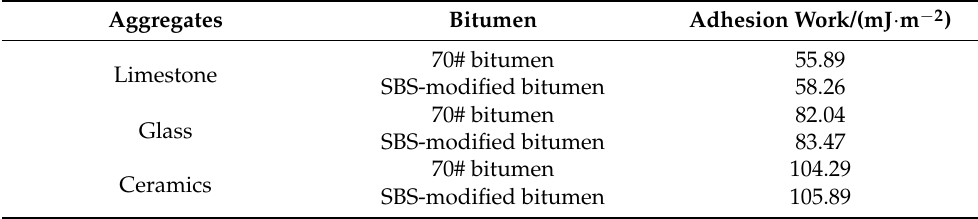
Table 9. Adhesion work between bitumen and